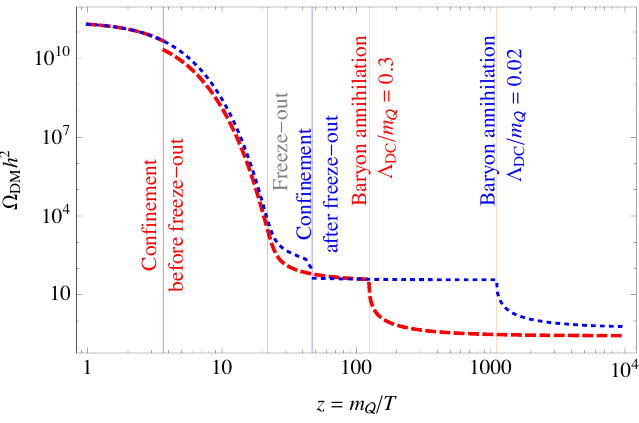
Figure 6 . The freeze-out history of two scenarios is displayed. The red line corresponds to con(cid:12)nement which takes place before freeze-out and the blue line shows the freeze-out which is followed by con(cid:12)nement and condensation. In both scenarios at late times, once the velocity